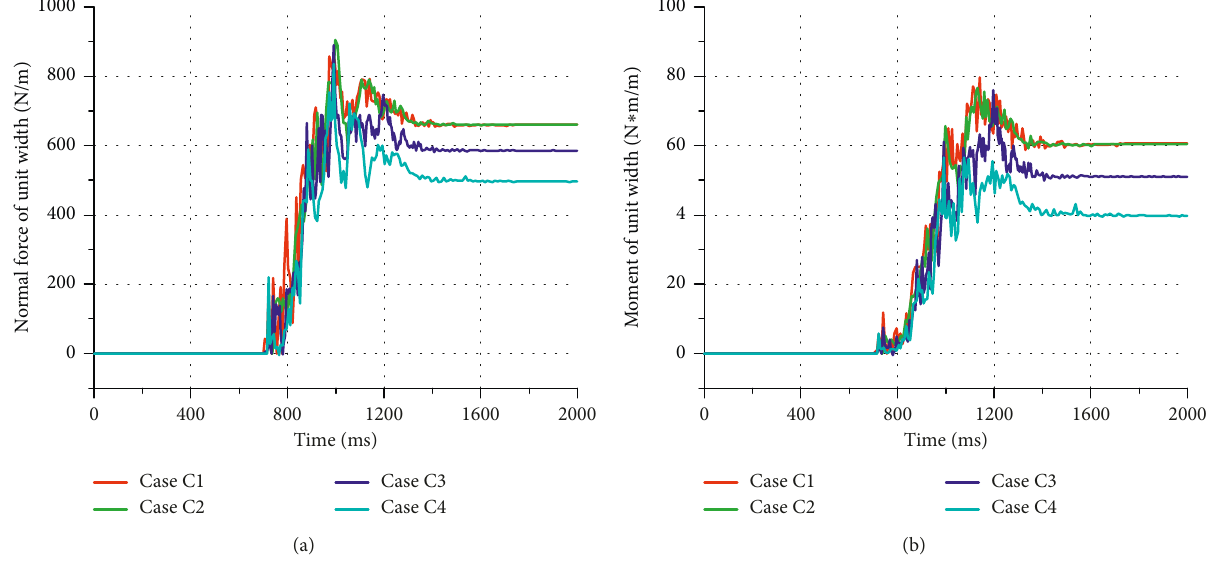
Figure 15: Time history of the impact of the granular flow on RNB with different mesh sizes: (a) time history of the unit-width normal force; (b) time history of the unit-width